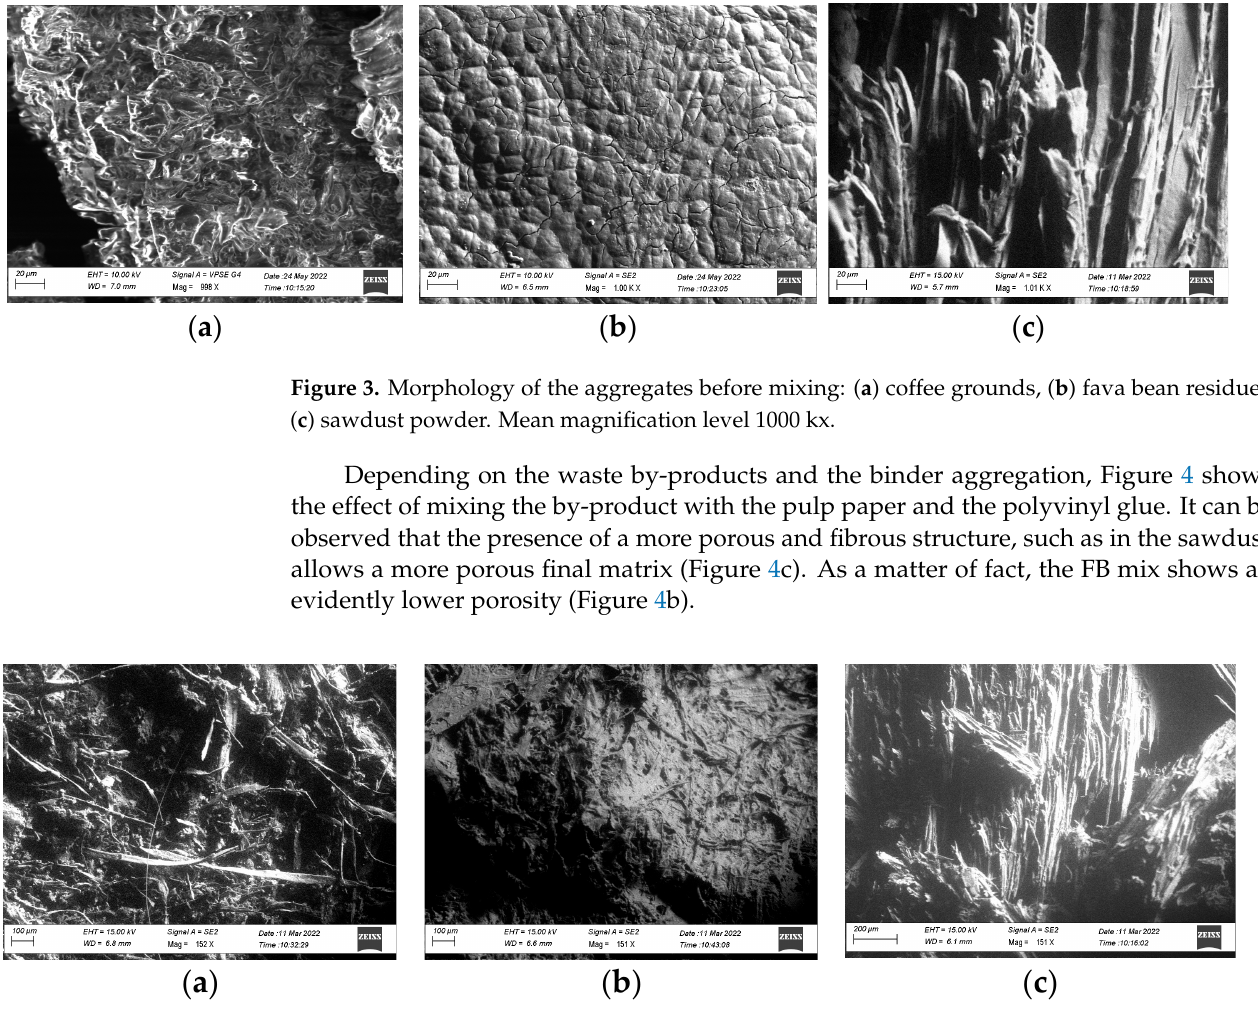
Figure 4. Morphology of the final specimens after mixing the pulp paper with aggregates: ( a ) coffee ground (CG), ( b ) fava bean residues (FB), ( c ) sawdust powder (SP). Mean magnification level 150 kx. In particular, the specimen with coffee grounds shows a tangled structure, evidencing the irregular shape of coffee powder flakes (Figure 4a). The fibrous matrix of the paper